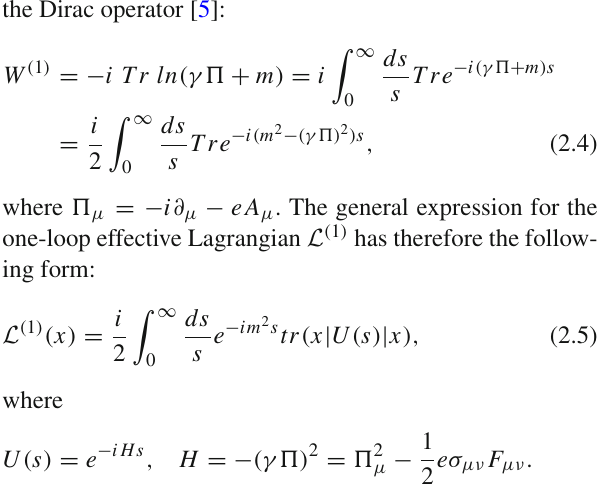
Fig. 2 Thegraphshowsthequalitativebehaviourofthevacuumenergy density (cid:8)( F ) (1.14),(4.16).Attheintersectionpoint F 0 (6.17)theeffec- tive coupling constant is small (6.18) and the intersection angle θ is strictly positive (6.19). The energy density curve can be continuously extended from the point F 0 deep into the negative energy density region arbitrary close to the value of the vacuum condensate (cid:3) F (cid:4) v ac by con- sidering a larger values of N and keeping the t’Hooft coupling constant g 2 N fixed(6.20),(6.21).Thisdemonstratethatthereisanonzeroenergy gap (cid:8) gap > 0 between perturbative and true vacuum states. The vac- uum is characterised by the nonzero value of the chromomagnetic field strength tensor (1.15), (6.8) and the energy density gap (cid:8) gap = | (cid:8) v ac | (1.17)